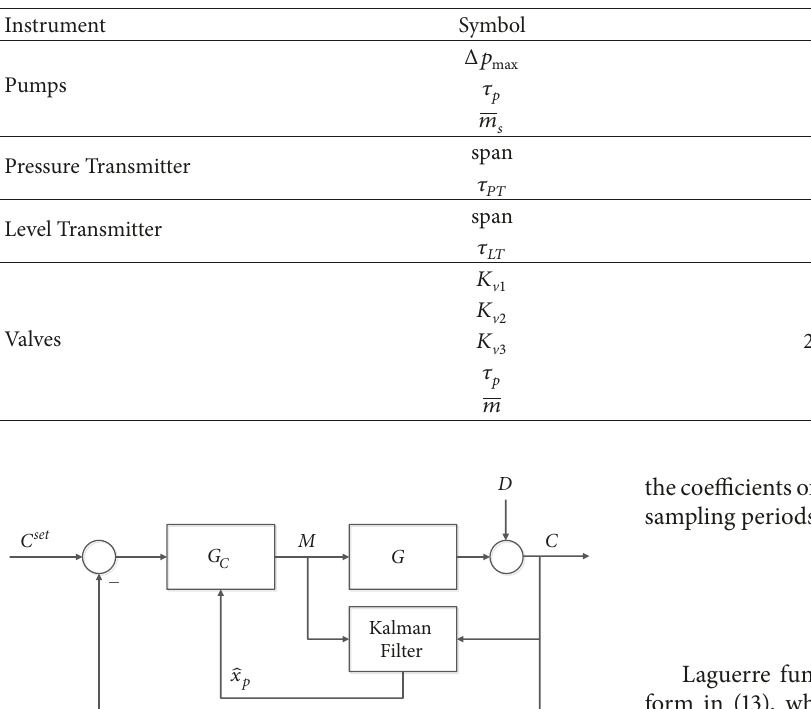
Figure 3: P&ID for a pipeline section. Table 2: Sensors and final control elements features.